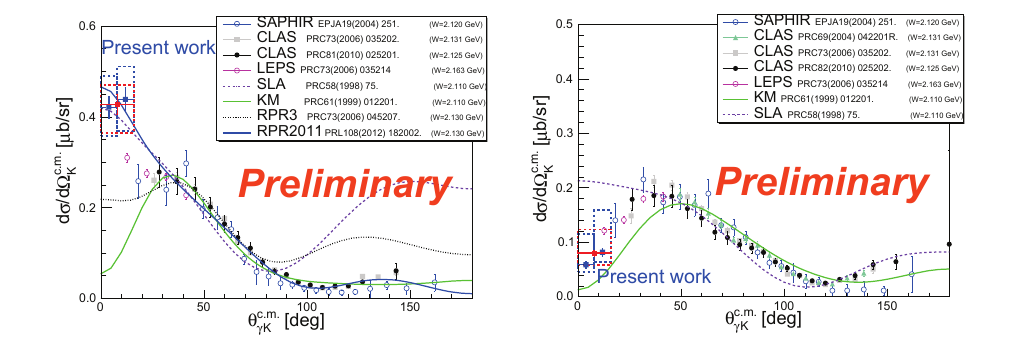
Figure 4. The θ c . m . dependency of the di ff er- γ K ential cross sections for the Λ hyperon produc- tion. Our data is at Q 2 ∼ 0 . 5 (GeV / c ) 2 , the others are at Q 2 = 0 (see text).